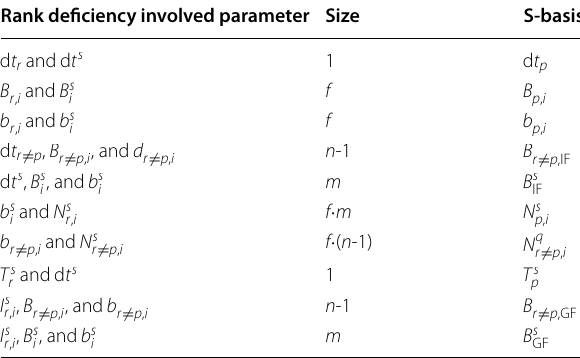
Table 1 The rank deficiencies information, including involved parameters, sizes, and S-basis for PPP–RTK network Rank deficiency involved parameter Size S-basis